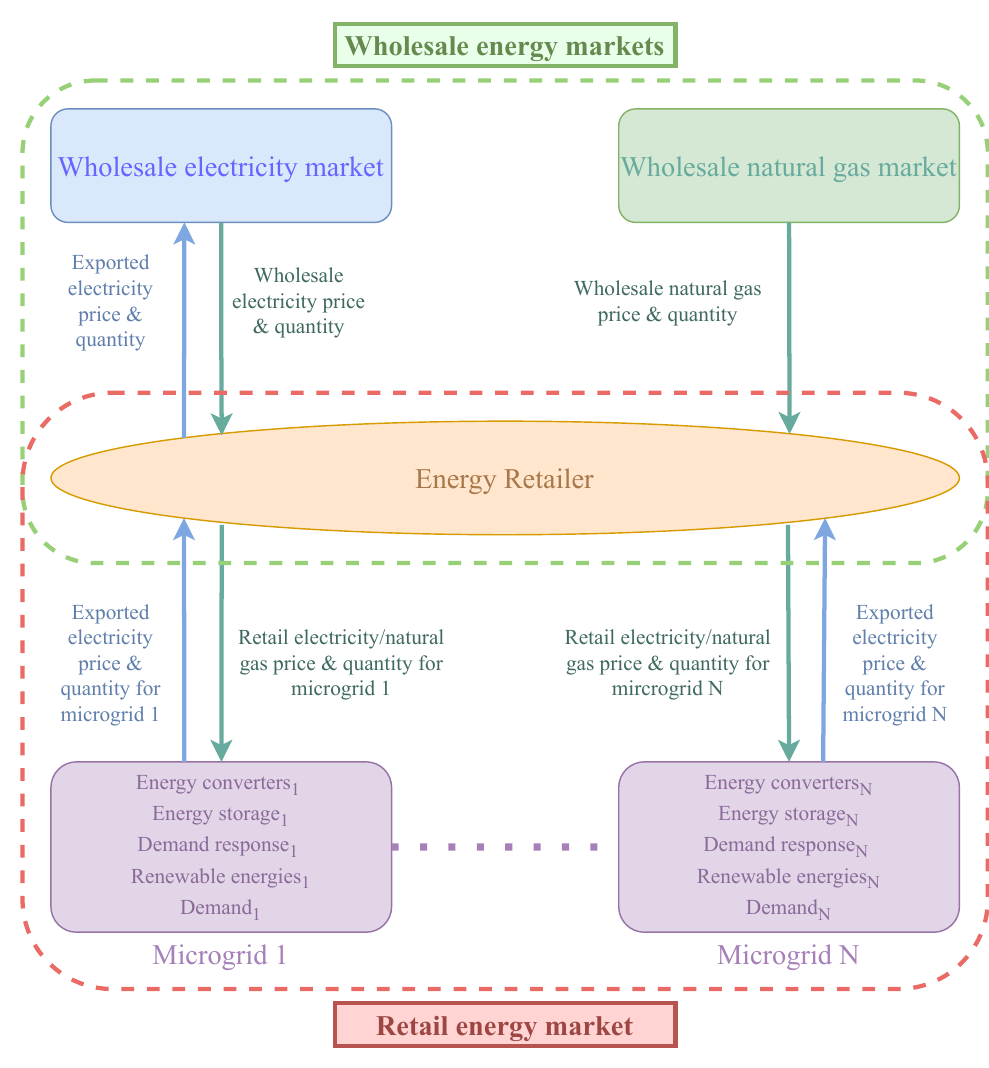
Figure 1. Structure of the multi-energy